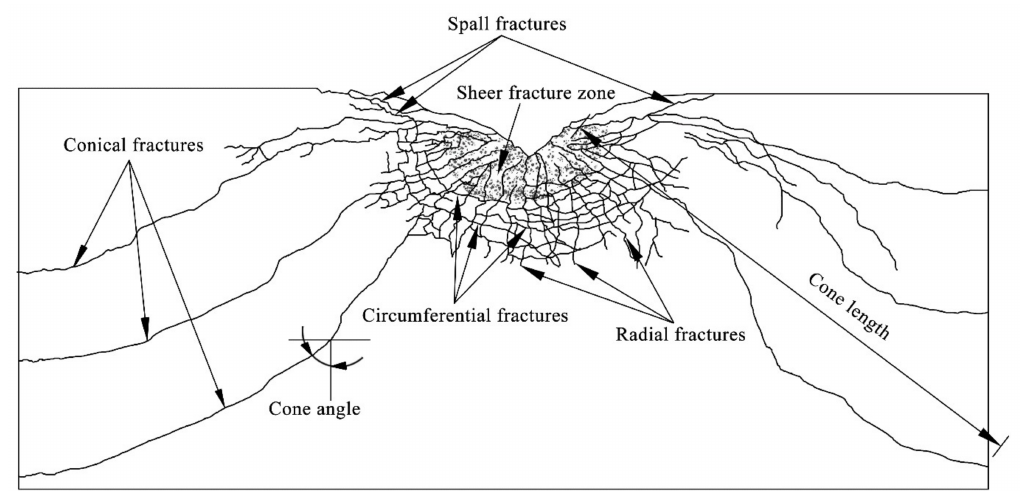
Figure 7. Crack patterns observed outside and inside the rock samples impacted by water